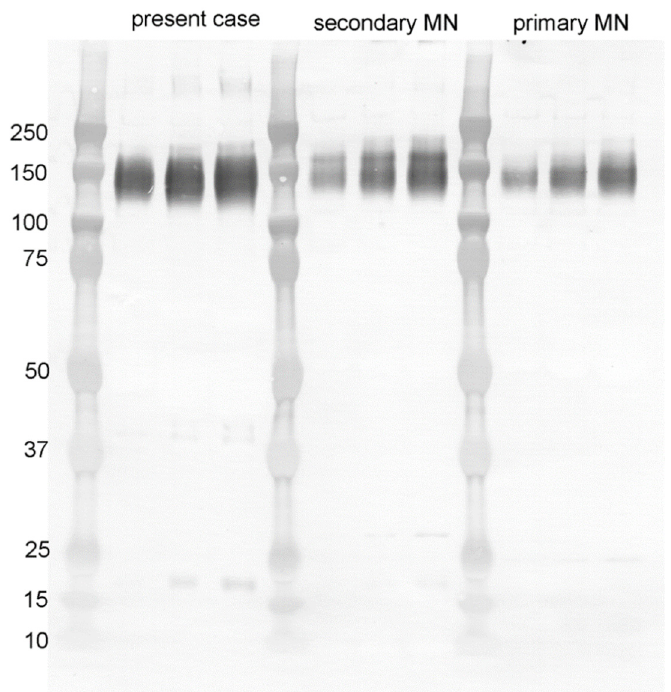
Figure 5. Western blot of the urinary protein at the time of renal biopsy for p16-INK4a. The urine of the present case showed a band at MW16kD, whereas the urine of other cases of membranous nephropathy did not show a band for p16-INK4a.